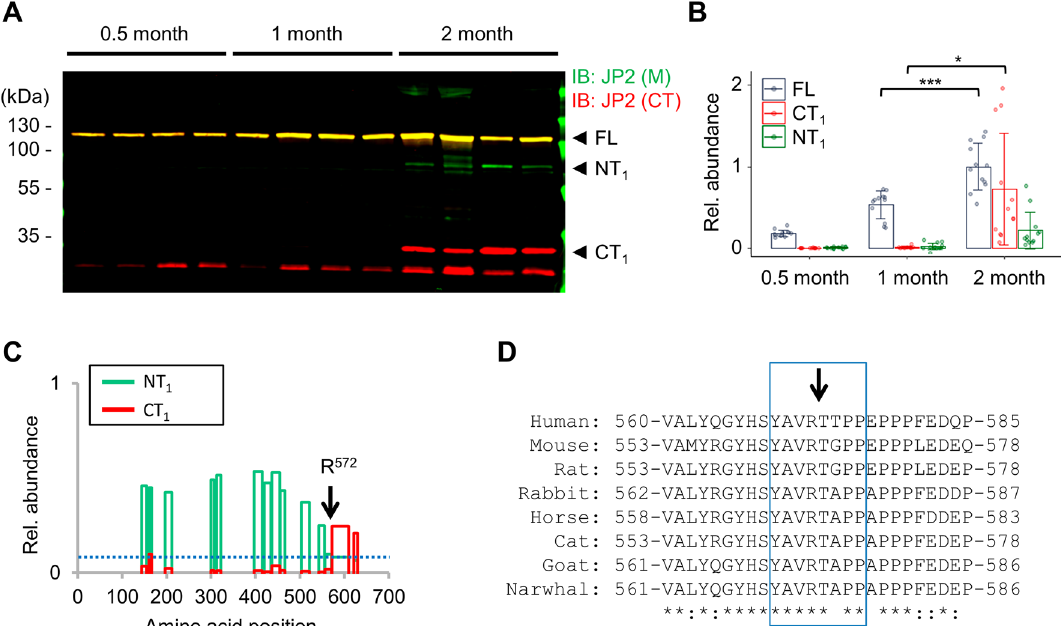
Figure 5. Calpain-specific cleavage fragments of JP2 are significantly increased in hiPSC-CMs after 2 months maturation, but not after 0.5 or 1 month differentiation. ( A ) Representative Western blot showing the protein levels of FL JP2 versus the Calpain-specific cleavage fragments. Both NT 1 and CT 1 were detected only after 2 months maturation, in contrast to the shorter 0.5 and 1 month hiPSC-CM differentiation time points. ( B ) Dot/bar plot quantifiying the Western blot data presented as mean ± SD (n = 4 biological replicates). Student’s t-test; *p < 0.05; ***p < 0.001. ( C ) Targeted data-dependent LC-MS/MS analysis of human Calpain-specific JP2 cleavage products in 2 months matured hiPSC-CMs. The relative abundance of the tryptic peptide peak areas of the endogenous human Calpain cleavage fragments is plotted versus the JP2 amino acid position including the primary human JP2 cleavage site R572 as indicated. ( D ) Sequence alignment confirming the high conservation of the primary Calpain cleavage site of JP2 across mammalian species from human to narwhal. Sequences human: NP_065166.2 (Homo sapiens); mouse: NP_001192005.1 (Mus musculus); rat: NP_001033063.1 (Rattus norvegicus); rabbit: NP_001075467.1 (Oryctolagus cuniculus); horse: XP_023482375.1 (Equus caballus); cat: XP_023106984.1 (Felis catus); goat: XP_017913386.1 (Capra hircus); Narwhal: XP_029077086.1 (Monodon monoceros). Asterisks mark identical residues; colons indicate highly conserved